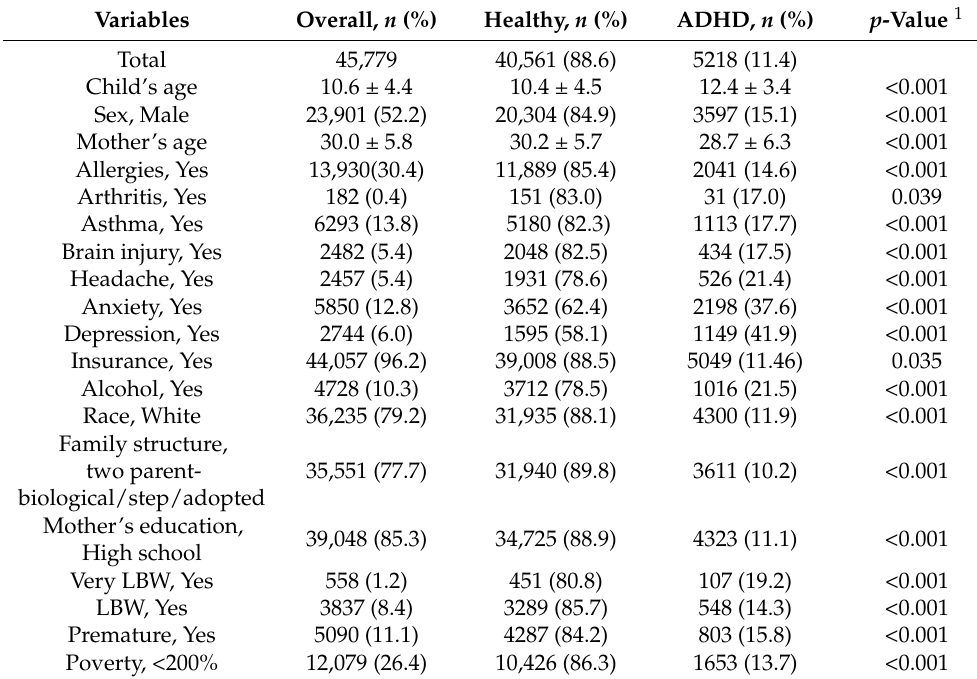
Table 3. Baseline and demographic characteristics of children with ADHD, 3–17